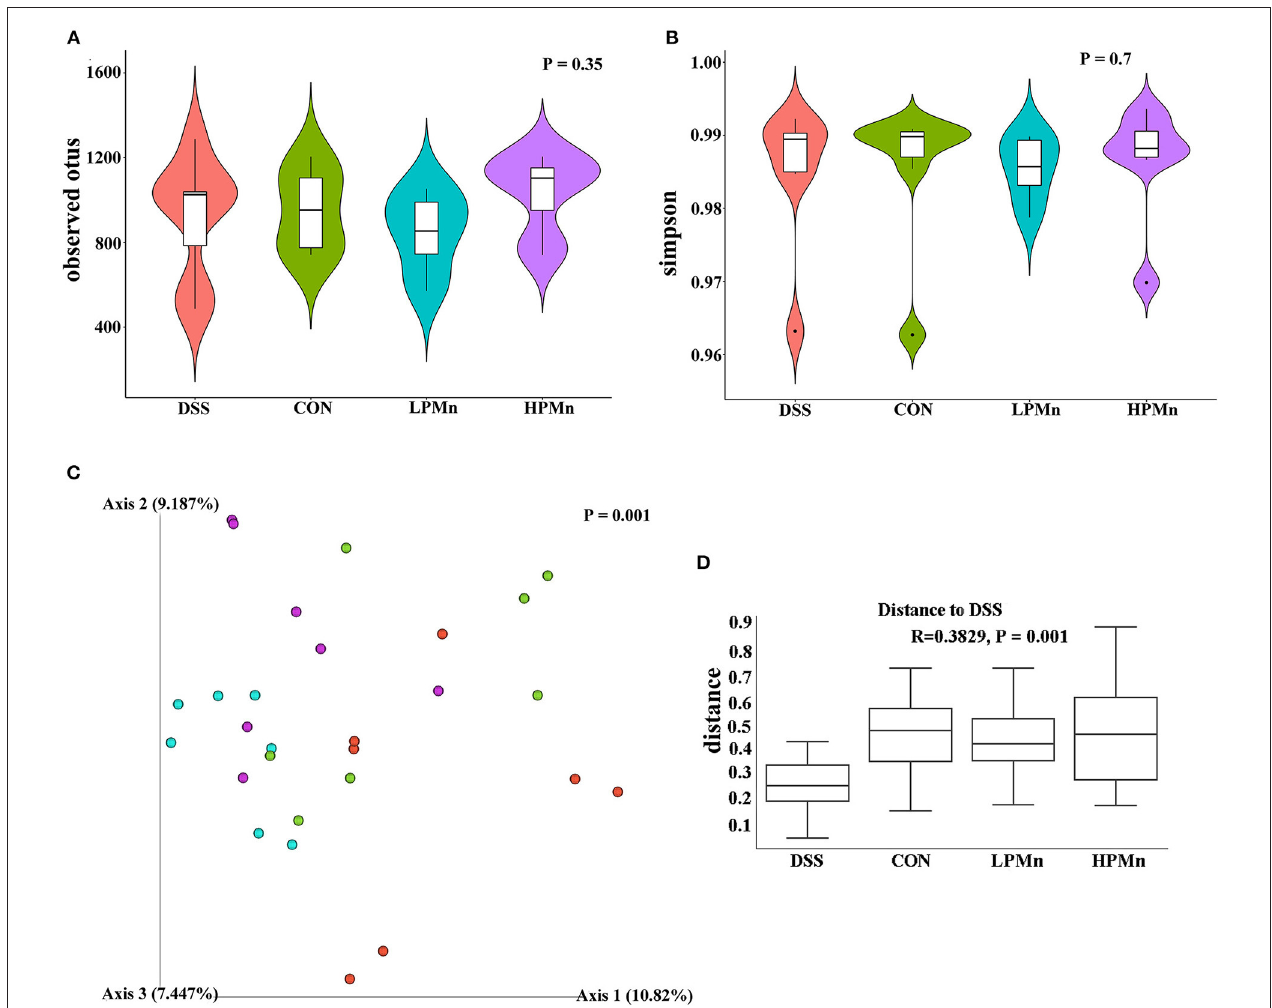
organism-level microbiome phenotypes were predicted using Bugbase. Aerobic